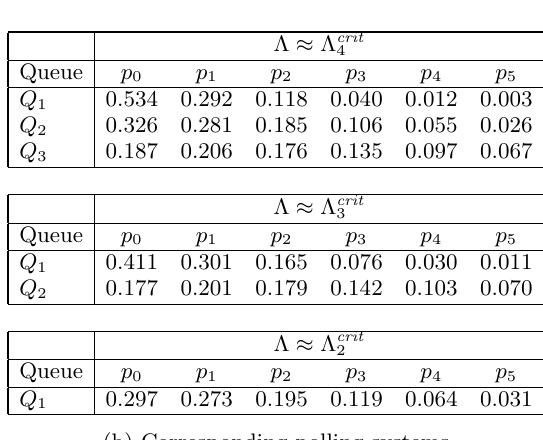
(b) Corresponding polling systems Table 5: Marginal queue lengths of the stable queues in the original polling and the corresponding sys- tems. The simulated probabilities P ( N i = m ), de- noted by p m , are given for m = 0 , 1 , 2 , . . . , 5. similar to (16), but with B (cid:48) 2 modified to include the service times and switch-over times of all overloaded queues, and B 1 the service time of an arbitrary customer in any of the stable queues. The values of η i , i = 1 , 2 , 3 , 4, equal 1 . 364, propriate value when considering the scaling (Λ crit